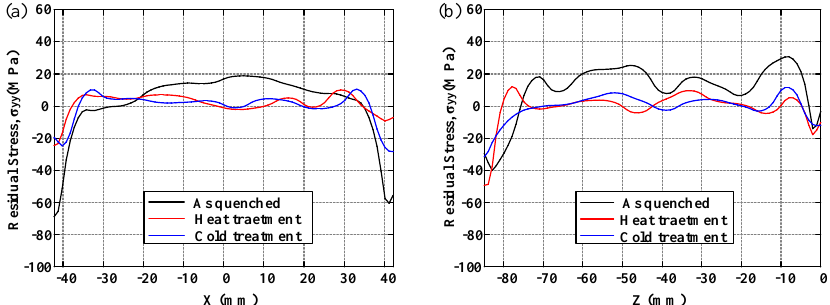
Figure 11. The distribution of long-transversal residual stress ( σ xx ): ( a ) along the y -direction at z = 42.4 mm; ( b ) along the z -direction at y = 0 mm. Materials 2018 , 11 , x FOR PEER REVIEW